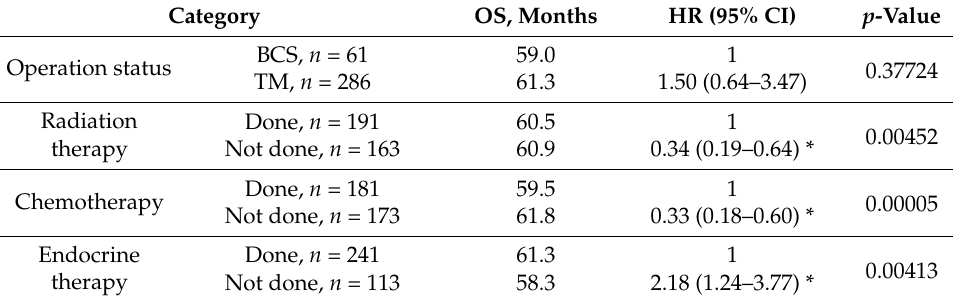
Table 2. Overall survival rates depending on type of